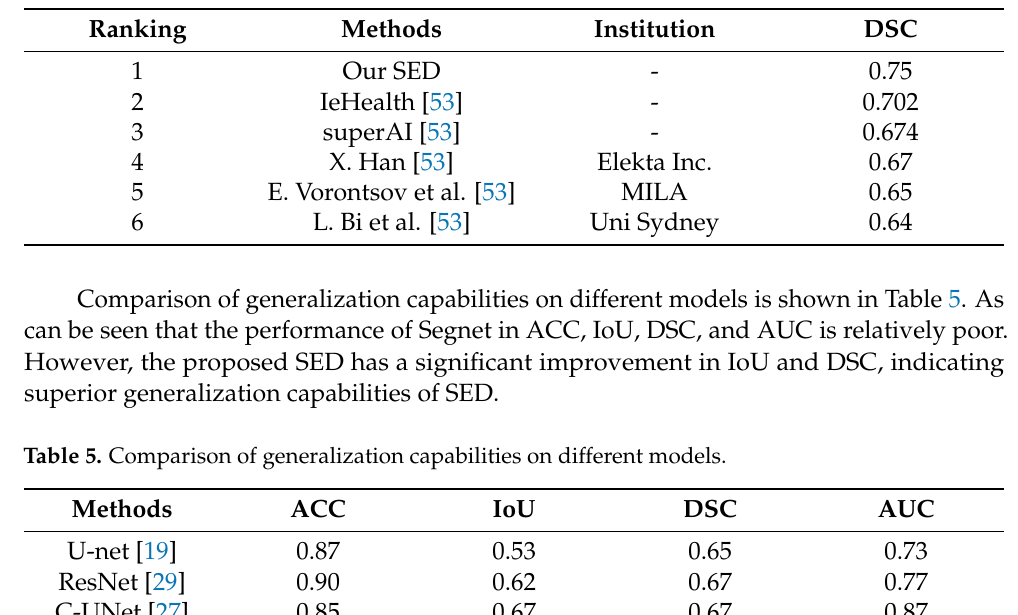
Table 4. DSC performance comparison with five models on ISBI 2017 Challenge.